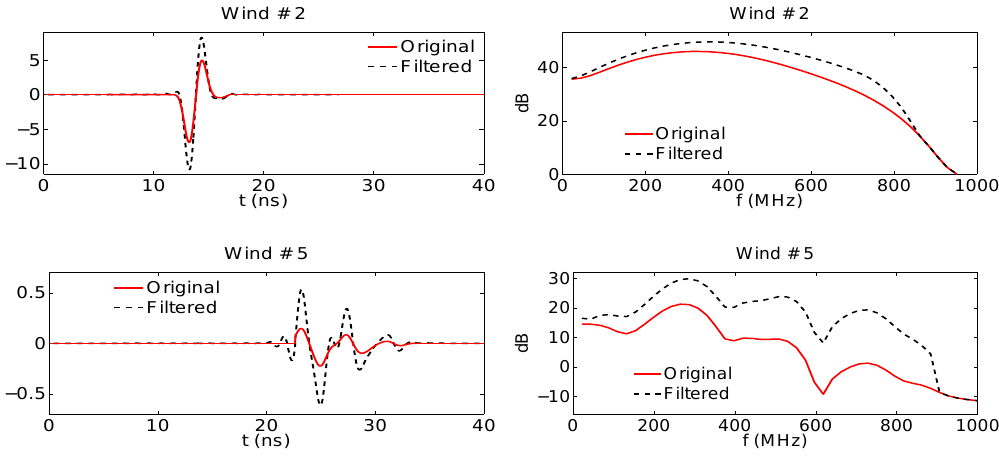
Figure 15. Time and Frequency domain representations for some of the windowed signals and their compensated counterparts after space and frequency dependent filtering.